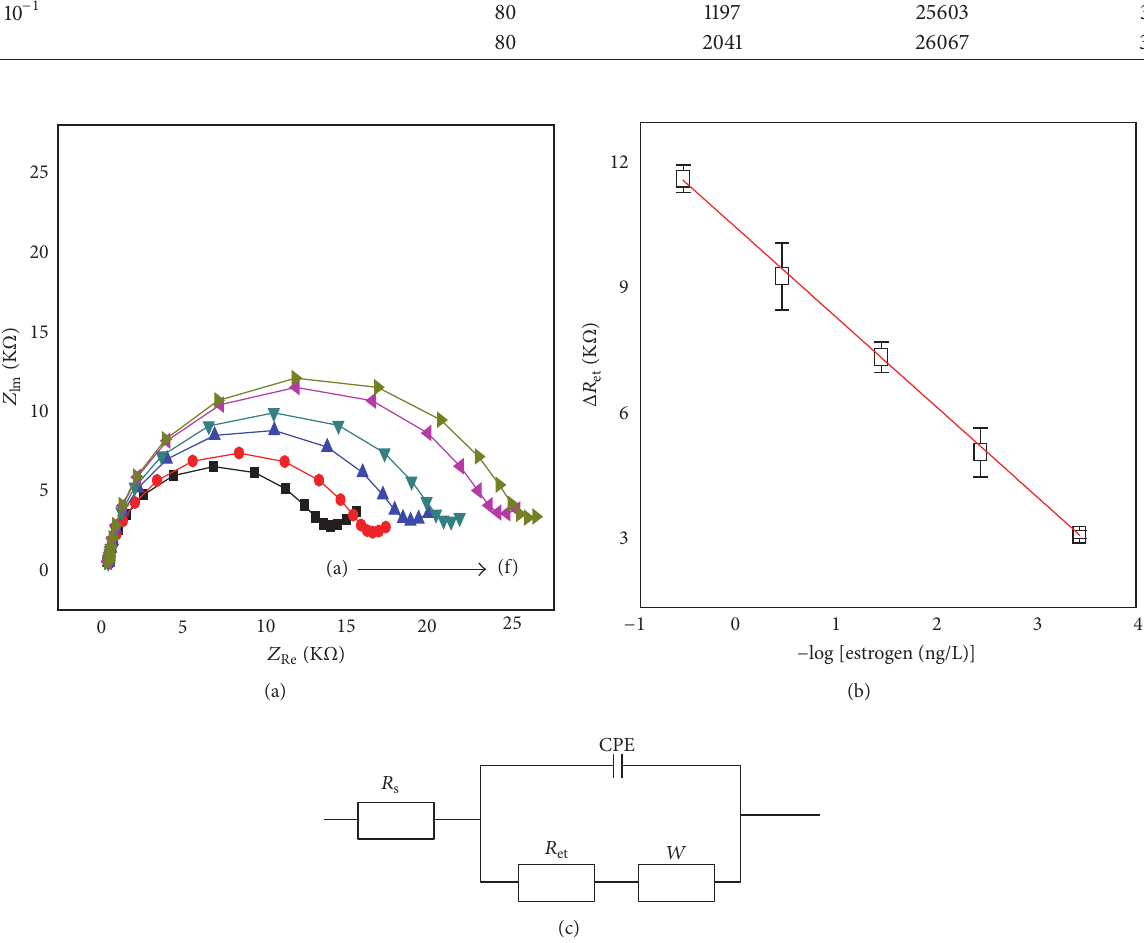
Figure 1: (a) Nyquist plots for the faradaic impedance measurements in the presence of 5.0 mM [Fe(CN) 6 ] 3−/4− at the estrogen biosensor before (A) and after the treatment of 3.7 × 10 −4 ng/L (B), 3.7 × 10 −3 ng/L (C), 3.7 × 10 −2 ng/L (D), 3.7 × 10 −1 ng/L (E), and 3.7 ng/L (F) of 17 𝛽 -estradiol in gas phase. (b) Plot of Δ𝑅 et versus − log [17𝛽 -estradiol ] . 𝑅 et (0) : electron transfer resistance at the estrogen biosensor before the treatment of 17 𝛽 -estradiol; 𝑅 et (𝑖) : electron transfer resistance at the estrogen biosensor after the treatment of a certain concentration of 17 𝛽 -estradiol. Δ𝑅 et = 𝑅 et (𝑖) − 𝑅 et (0) . (c) Four-component equivalent circuit, 𝑅 et : resistance of electron transfer, 𝑅 𝑠 : resistance of solution, 𝑊 : Warburg impedance, and CPE: constant phase